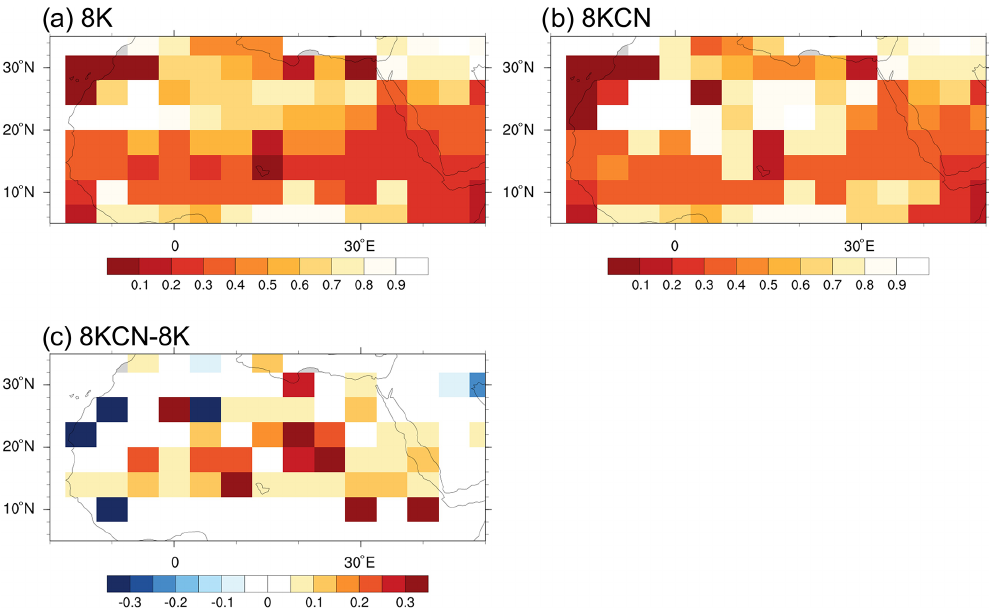
Figure 7. Downregulation fraction (GPP divided by GPP not limited by nitrogen) in the (a) 8K and (b) 8KCN simulations. Downregulation fraction difference between the 8KCN and 8K simulation (c)